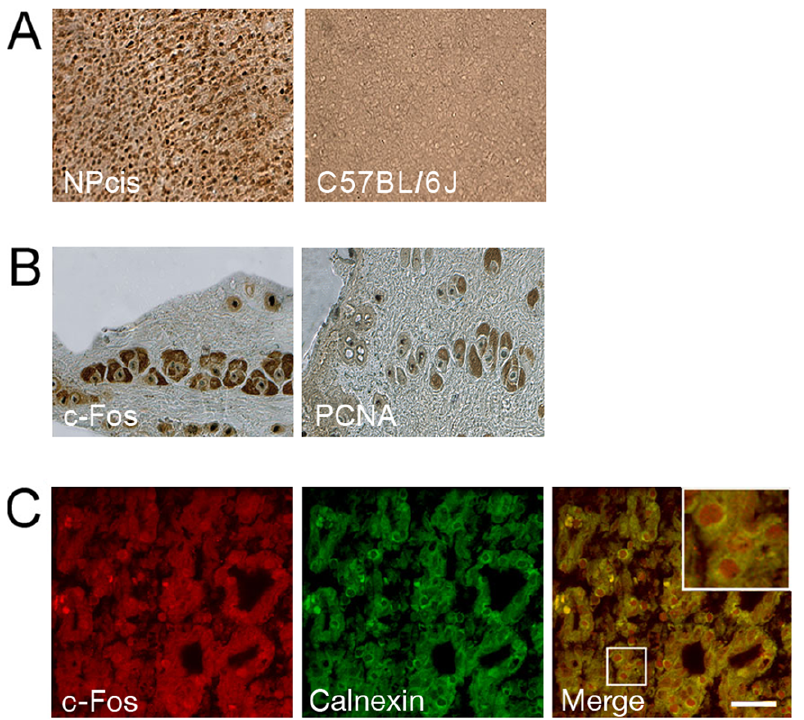
Figure 3. Expression and subcellular localization of c-Fos in CNS and PNS tumors from NPcis mice. ( A ) c-Fos expression was determined in mouse brain cortex from a tumor-bearing NPcis mouse (left) and a WT littermate (right) by staining with DAB-peroxidase. Note the abundant c-Fos expression in the NPcis sample, contrasting with the undetectable levels in the WT animal. ( B ) c-Fos (left) and PCNA (right) expression in peripheral nerve tumors stained as in (A). ( C ) Confocal immunofluorescence analysis of peripheral nerve tumors evidencing abundant c-Fos (red) and the ER marker Calnexin (green) immunolabeling. The merged image at right clearly shows c-Fos/ER co-localization. Three additional animals showed the same results as in (A), (B) and (C). Inset: magnification of the box delimited area. Bar: 20 m